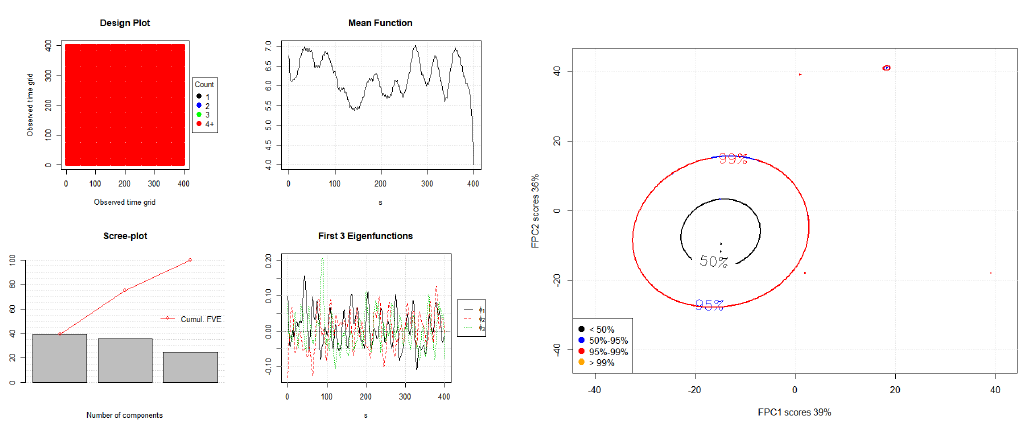
Figure 2. FPCA Plots of X 1 .